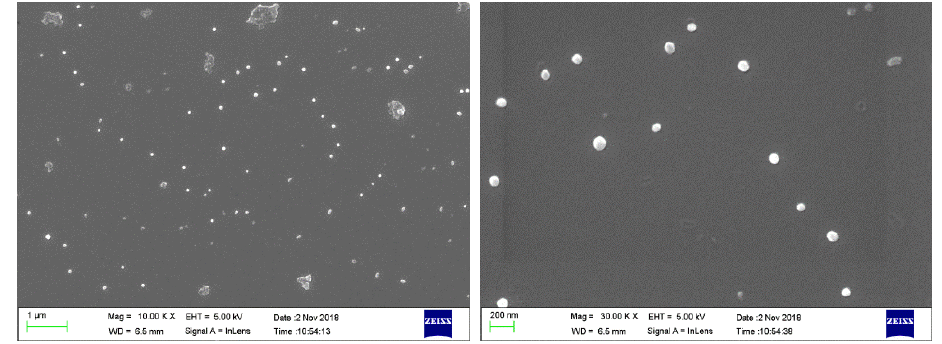
Figure 4. SEM images of CLNPs.